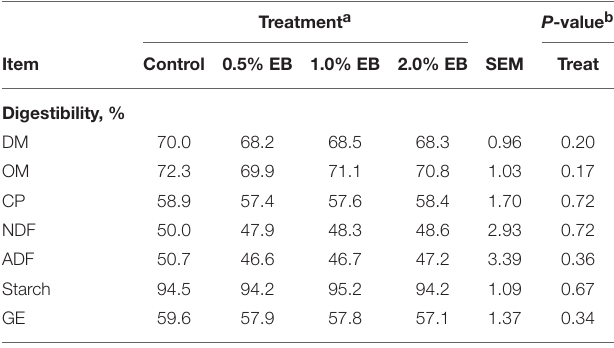
TABLE 7 | Energy balance of beef heifers fed a barley silage-based diet containing increasing addition of enhanced biochar (EB; n = 8 per treatment). Treatment a P -value